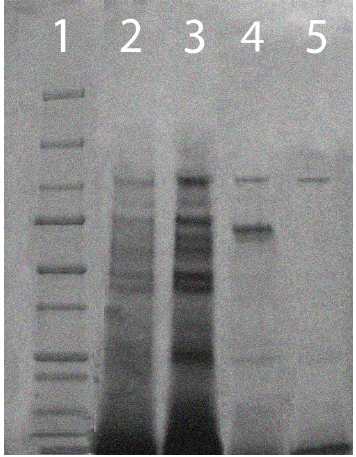
Figure 3. Enzyme purification was determined using 4%–15% gradient polyacrylamide gel electrophoresis. The lanes are as follows: (1) 250–10 kDa protein ladder; (2) crude sample; (3) concentrated sample; (4) Sephadex G-50 sample; and (5) purified